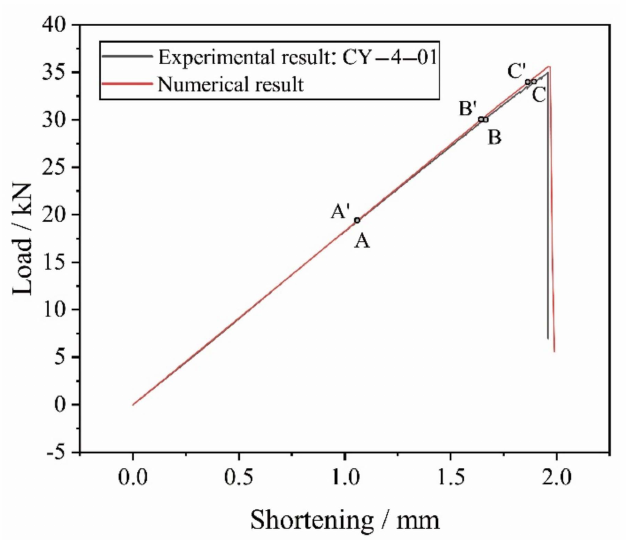
Figure 18. Comparison of the numerical and experimental results of load-shortening curves. On the experimental load-shortening curve of the CY-4-01 specimen, A, B and C are the points under the compression load of 20 kN, 30 kN, and 34 kN, respectively. A’, B’, and C’ are the points corresponding to A, B, and C, respectively on the numerical load-shortening curve. The predefined field variables (FV) are used in describing the intra-laminar damage and the numerical results indicate that the fiber compressive failure (described by FV2) is the dominant failure mode of the open-hole